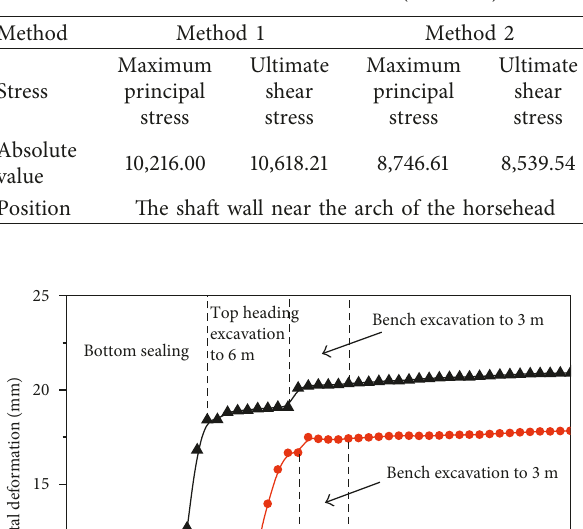
Table 4: Maximum deformation of shaft (unit: mm).